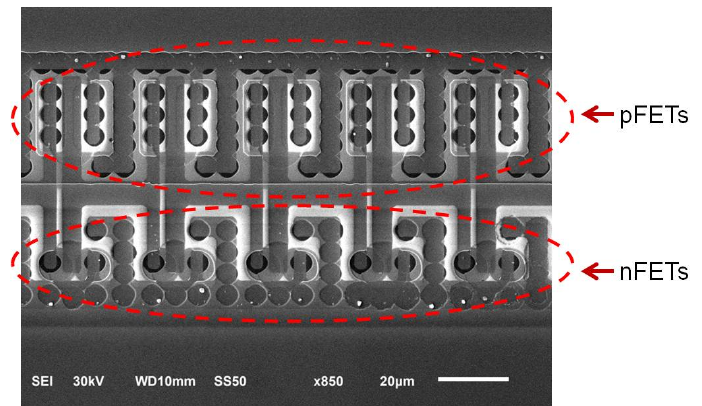
Figure 9. SEM image of a complementary metal-oxide semiconductor (CMOS) ring oscillator fabricated with HfO 2 or ZrO 2 as the gate oxide.